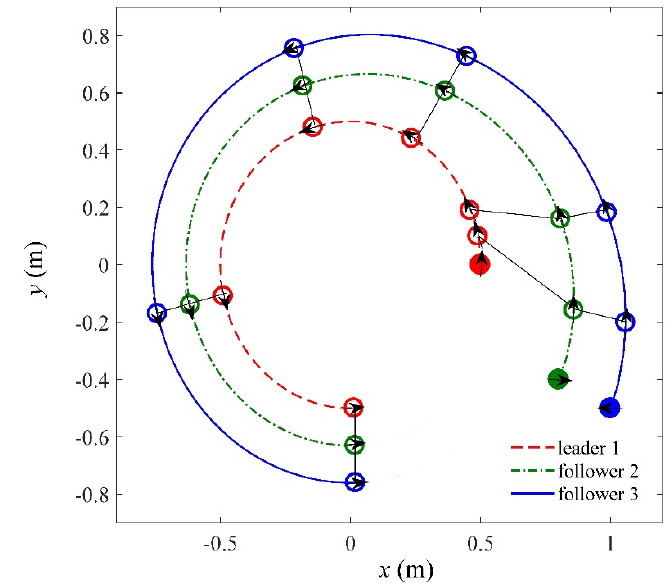
Figure 3. Moving trajectory of leader–follower formation system.